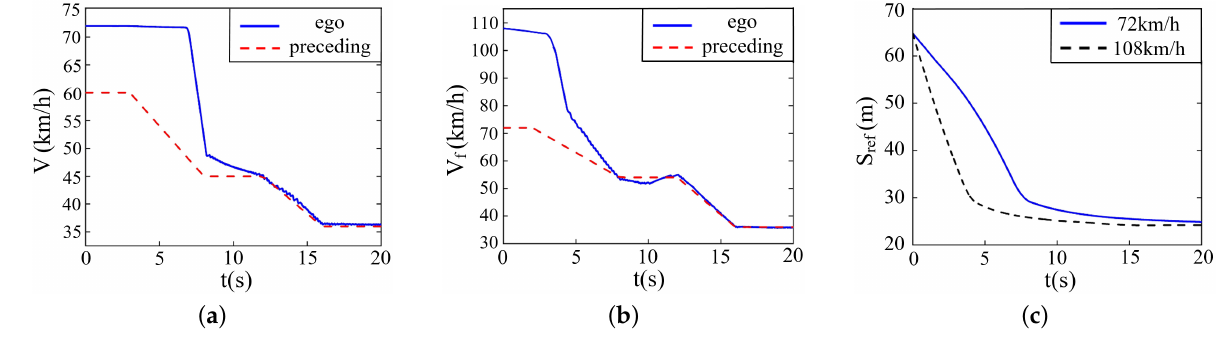
Figure 16. Simulation on curved roads when the preceding vehicle drives at various speeds. ( a ) Ve- locity (72 km/h). ( b ) Velocity (108 km/h). ( c ) Relative